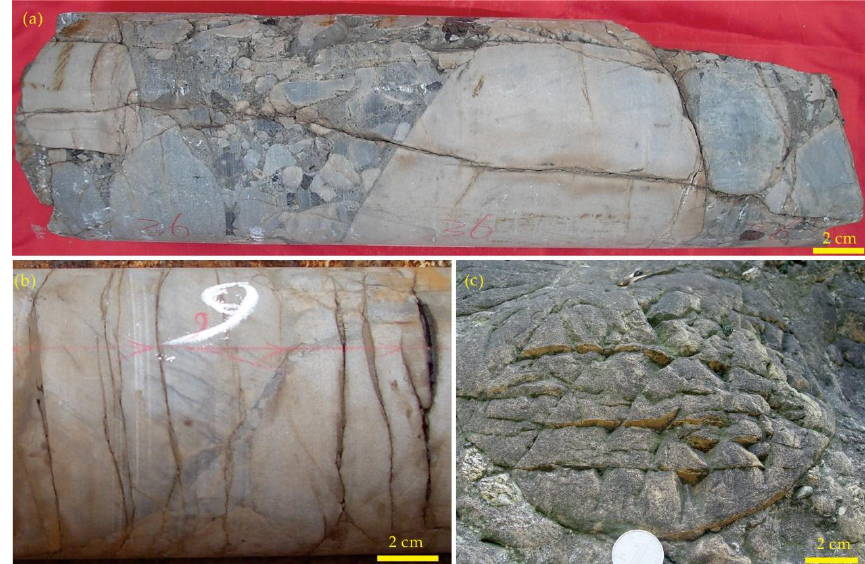
Figure 6. Trans-gravel fractures in cores and out crop. ( a ) Trans-gravel fractures with high dip angle in core, Well L102, 3185.75 m; ( b ) trans-gravel fractures with low dip angle in core, Well L104, 3174.65 m; ( c ) conjugate fractures in outcrop, see Figure 1 for outcrop location.